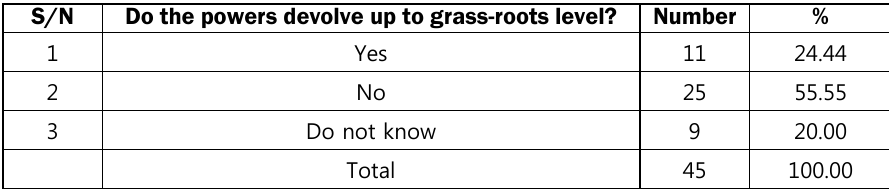
TABLE 12: Officials’ views about the powers devolved up to grassroots level in city governance S/N Do the powers devolve up to grass-roots